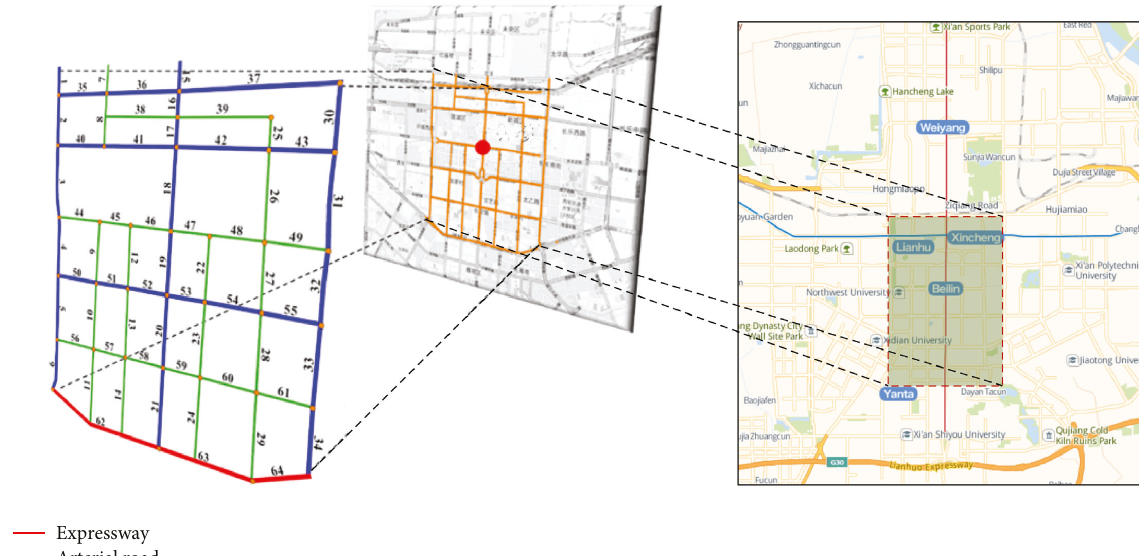
Figure 6: The research scope